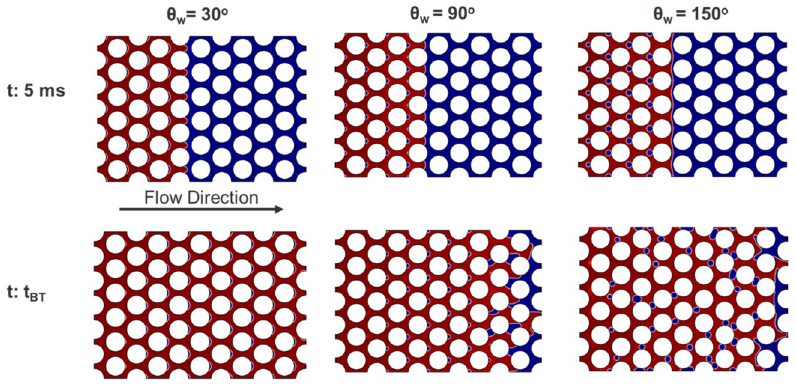
Figure 5. The dynamics of air (red) displacing water (dark blue) at log Ca = − 4 and Log M = − 2. The medium has homogeneous wettability presented by constant contact angle (30°, 90° and 150°) with respect to the defending phase.